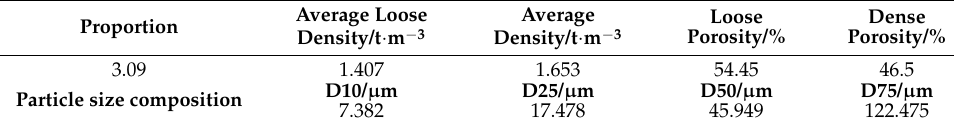
Table 2. Mass fraction of main chemical components of tailings